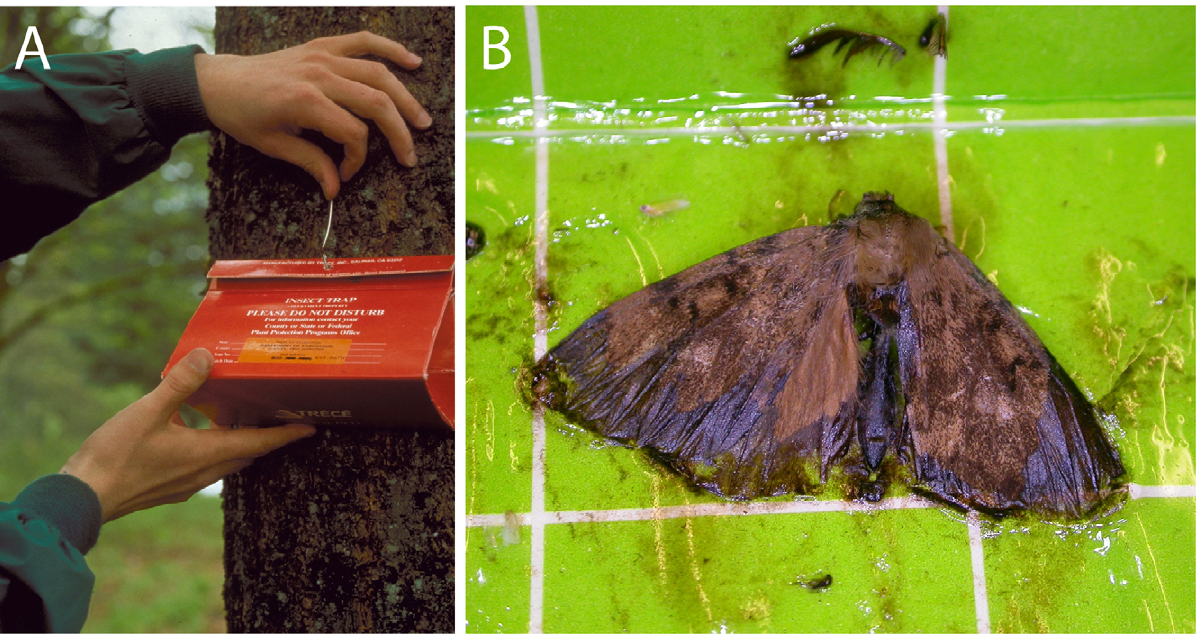
Figure 1. Collection of specimens through a pheromone-based gypsy moth surveillance program. A, Pheromone trap and B, trapped and damaged Lymantria dispar specimen (LMHRG001-06) (image A from USDA APHIS PPQ Archive, USDA APHIS PPQ, Bugwood.org).